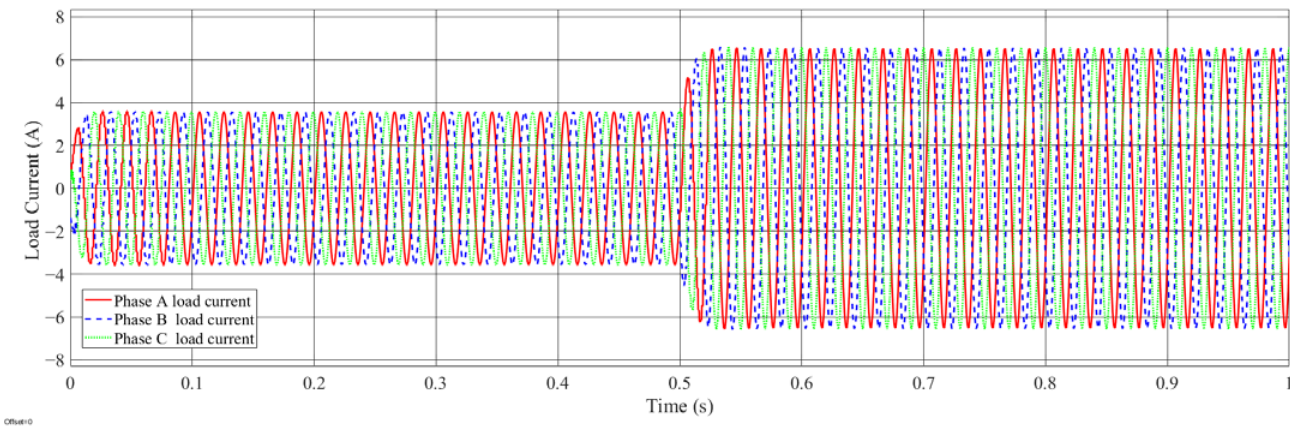
Figure 9. System load current with NLIB controller in three phase (ABC) frame.